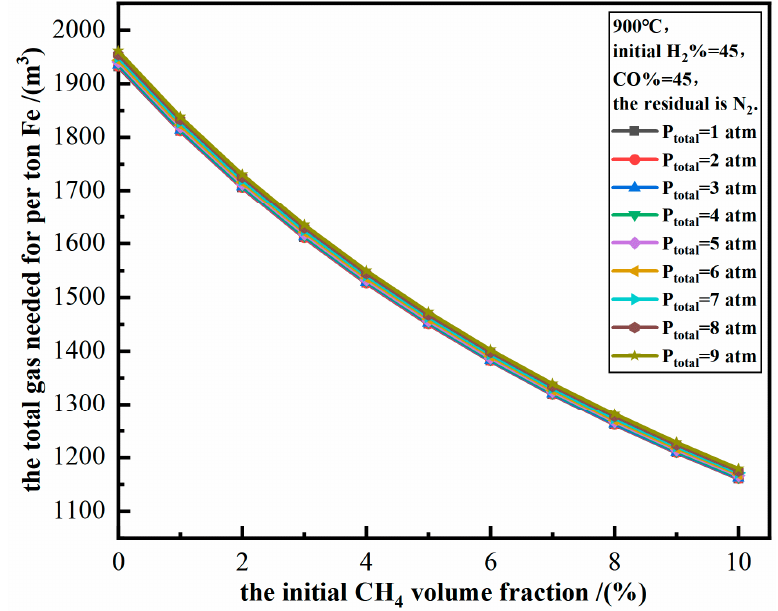
Figure 5. The relationship between the volume for total gas needed for per ton Fe and initial CH 4 volume fraction at 900 °C with the initial H 2 % = 45 and CO% = 45 under 1–9 atm.